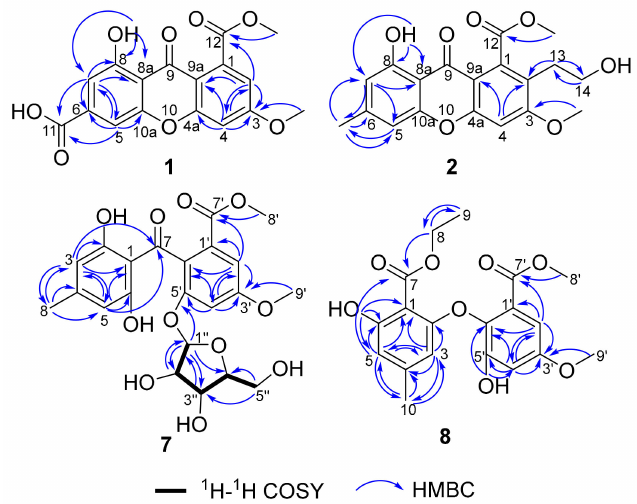
Figure 2. HMBC correlations of compounds 1 , 2 , 7 , and 8 and selected 1 H– 1 H COSY of compound